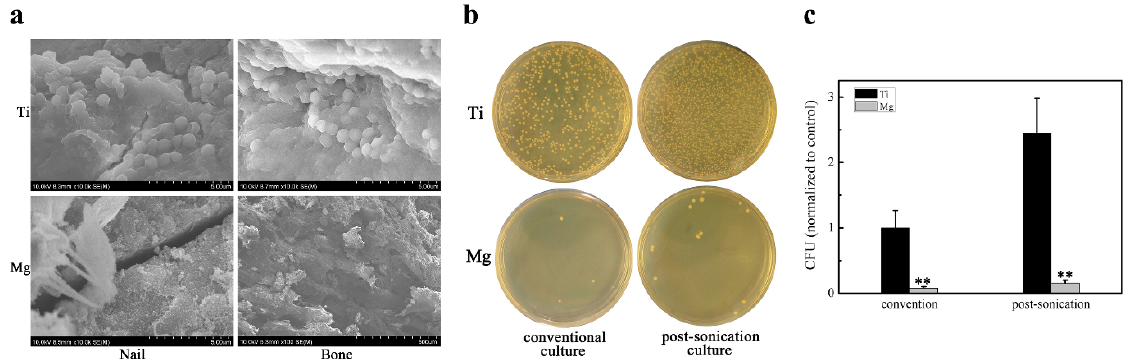
Figure 8. The in vivo antibacterial activity of Mg compared with Ti. ( a ) SEM pictures illustrating the residual bacteria adhered on the Mg or Ti surface and surrounding tissues. ( b ) Representative images of viable bacteria on peri-implant bone tissues and implanted nails; ( c ) the cumulative numbers of bacterial colonies in the Mg group after normalization. ** p < 0.01. Reproduced with permission from [121]. Copyright 2014, American Society for Microbiology.